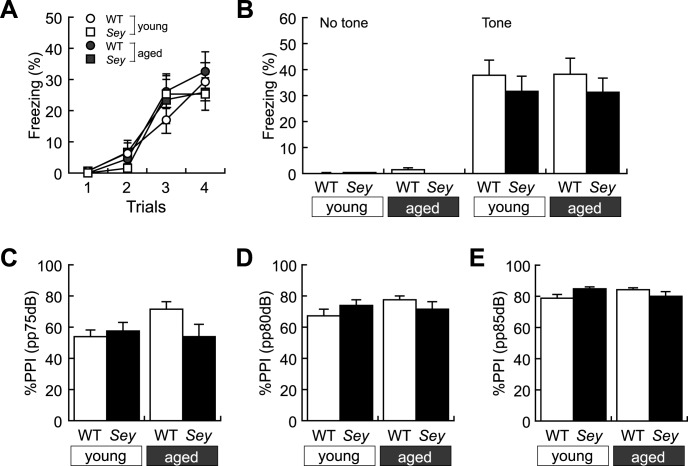
Fear memory and sensorimotor gating of WT and Sey/+ mice.Fear memory of each mouse was recorded in the cue-dependent fear conditioning test. Histogram showing results of (A) freezing ratio (%) for conditioning; three-way ANOVA: main effect of “trial”; F = 34.448, p < 0.001, but no main effect of “genotype”; F = 0.167, p = 0.683, “father’s age”; F = 0.599, p = 0.440, and interaction (father’s age x genotype); F = 0.100, p = 0.753, (father’s age x trial); F = 0.109, p = 0.955, (genotype x trial); F = 0.509, p = 0.676, (father’s age x genotype x trial); F = 0.657, p = 0.580, (B) freezing ratio (%); two-way ANOVA: no main effect of “genotype”; F = 1.252, p = 0.270 and “father’s age”; F < 0.001, p = 0.985, and interaction (father’s age x genotype); F = 0.015, p = 0.904 in the cue-dependent fear conditioning test. Sensorimotor gating of each mouse was recorded in the prepulse inhibition test. Histogram showing results of %PPI in (C) prepulse (pp) 75dB; two-way ANOVA: no main effect of “genotype”; F = 1.683, p = 0.202 and “father’s age”; F = 1.892, p = 0.177, and interaction (father’s age x genotype); F = 3.981, p = 0.053, in (D) pp80dB; two-way ANOVA: no main effect of “genotype”; F = 0.010, p = 0.922 and “father’s age”; F = 1.021, p = 0.318, and interaction (father’s age x genotype); F = 2.500, p = 0.122, and in (E) pp85dB; two-way ANOVA: no main effect of “genotype”; F = 0.295, p = 0.590 and “father’s age”; F = 0.057, p = 0.813, and interaction (father’s age x genotype); F = 5.438, p = 0.025 in the prepulse inhibition test in WT and Sey/+ mouse pups born to young (3M) or aged (>12M) father. All data are presented by the mean ± SEM. *p < 0.05, determined by Bonferroni post hoc test. WT: wild type, Sey: Pax6 mutant.